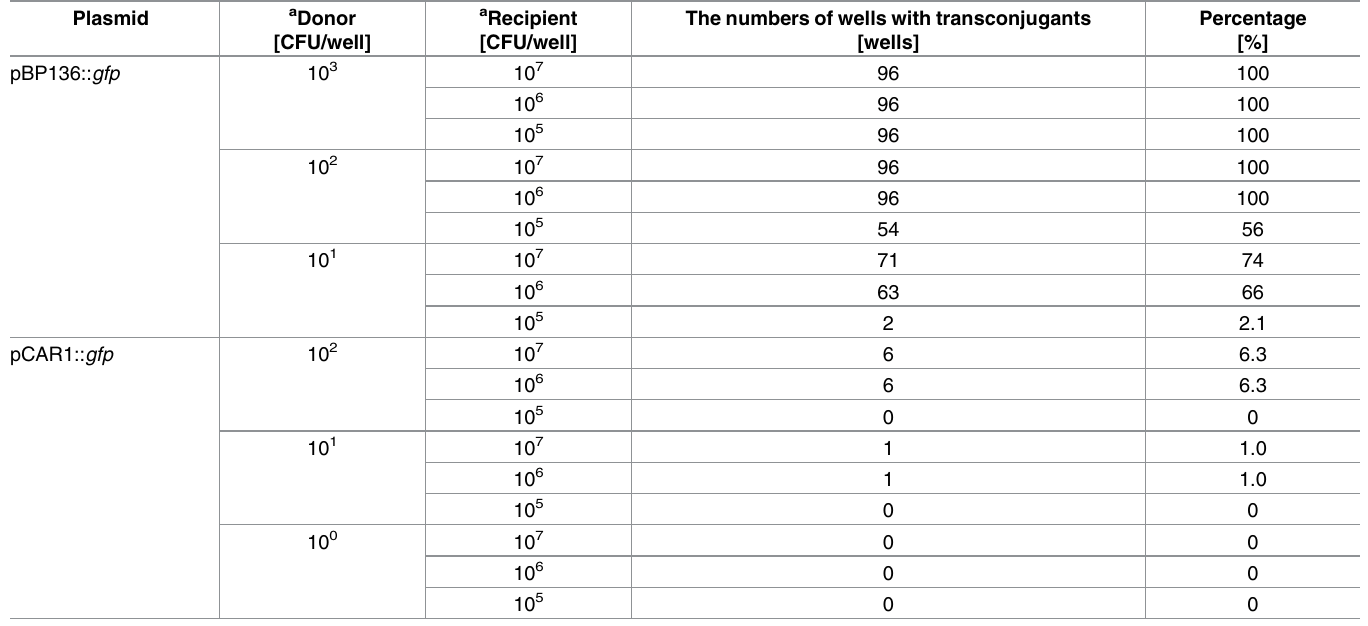
a The numbers of donor and recipient cells were only counted in the samples with the highest cell density. Donor of pBP136:: gfp or pCAR1:: gfp was 4.9 × 10 3 and 1.8 × 10 2 , respectively, while the recipients of them were 3.2 × 10 7 and 5.3 × 10 7 , respectively.